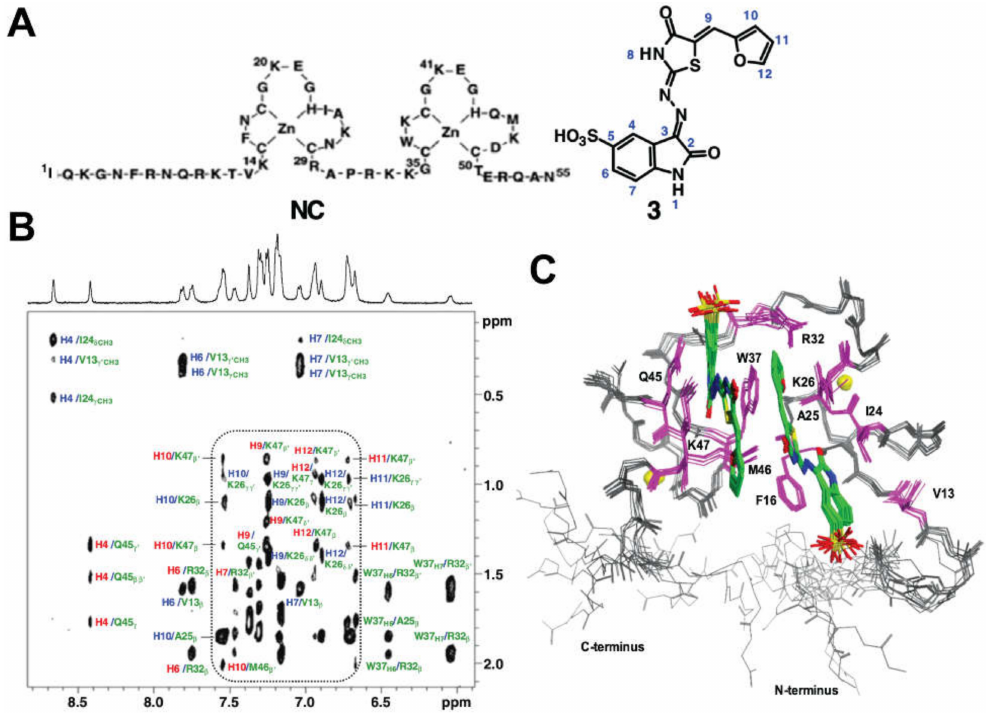
Figure 18. Small molecule inhibitors of NC-oligonucleotide binding. ( A ) NC protein and small molecule (Inhibitor-3) used for structural studies. ( B ) 2D NOESY data for the NC:Inhibitor-3 complex. ( C ) NMR structure of the NC:Inhibitor-3 complex (carbon atoms in green). Adapted from [390], with